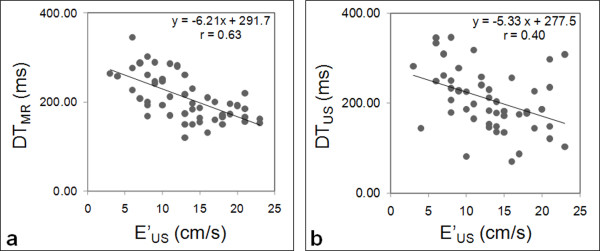
Comparison of the echocardiographic and the CMR deceleration times against the echocardiographic mitral annulus peak longitudinal velocity. Panel a: comparison between the echocardiographic mitral annulus peak longitudinal velocity (E'US) and the CMR deceleration time (DTMR). Panel b: comparison between the echocardiographic mitral annulus peak longitudinal velocity (E'US) and the echocardiographic deceleration time (DTUS).